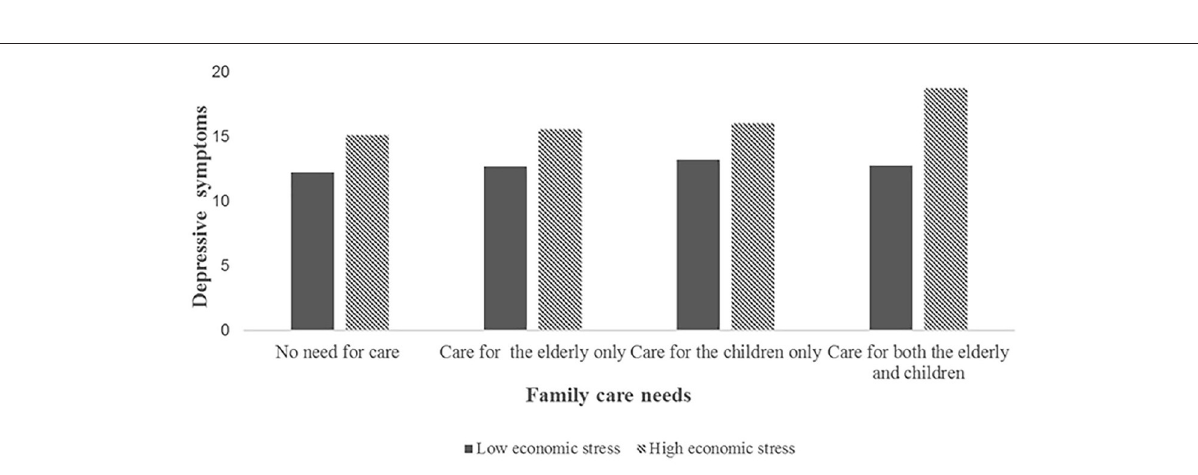
FIGURE 3 | The interaction effect of family care needs and economic stress on depressive symptoms in the urban sample.